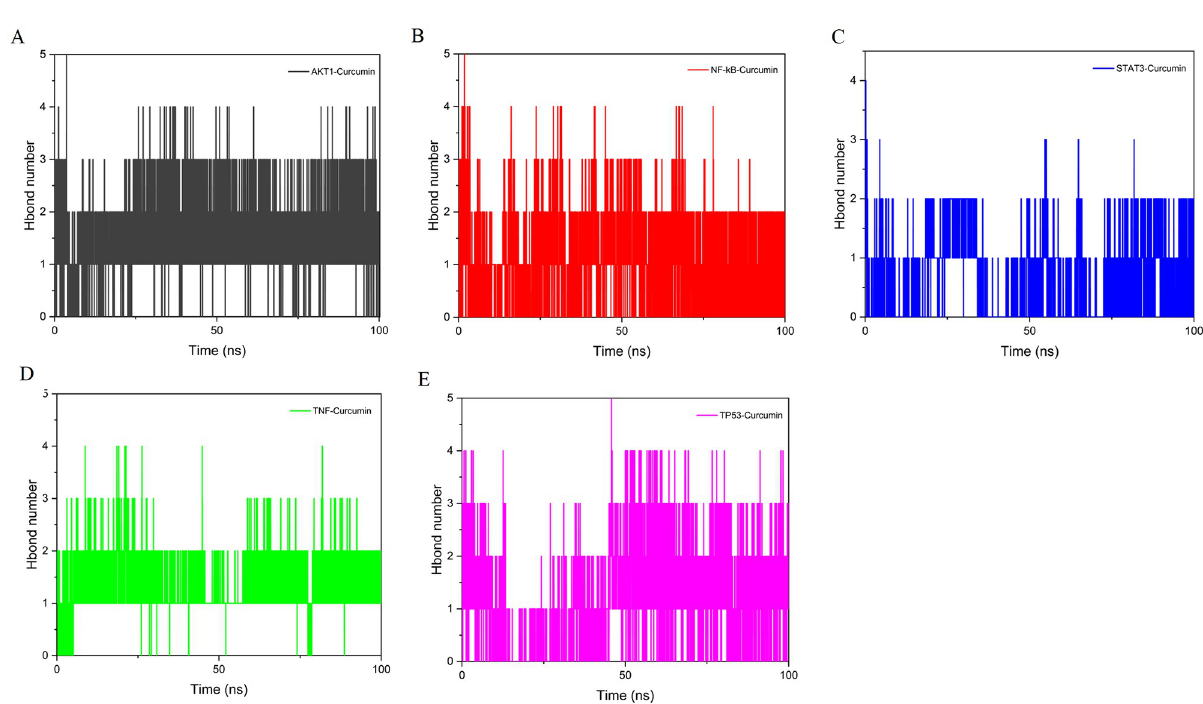
Fig 9. Hydrogen bond number of complex. (A) AKT1–curcumin. (B) NF- κ B–curcumin. (C) STAT3–curcumin. (D) TNF–curcumin. (E) TP53– curcumin.